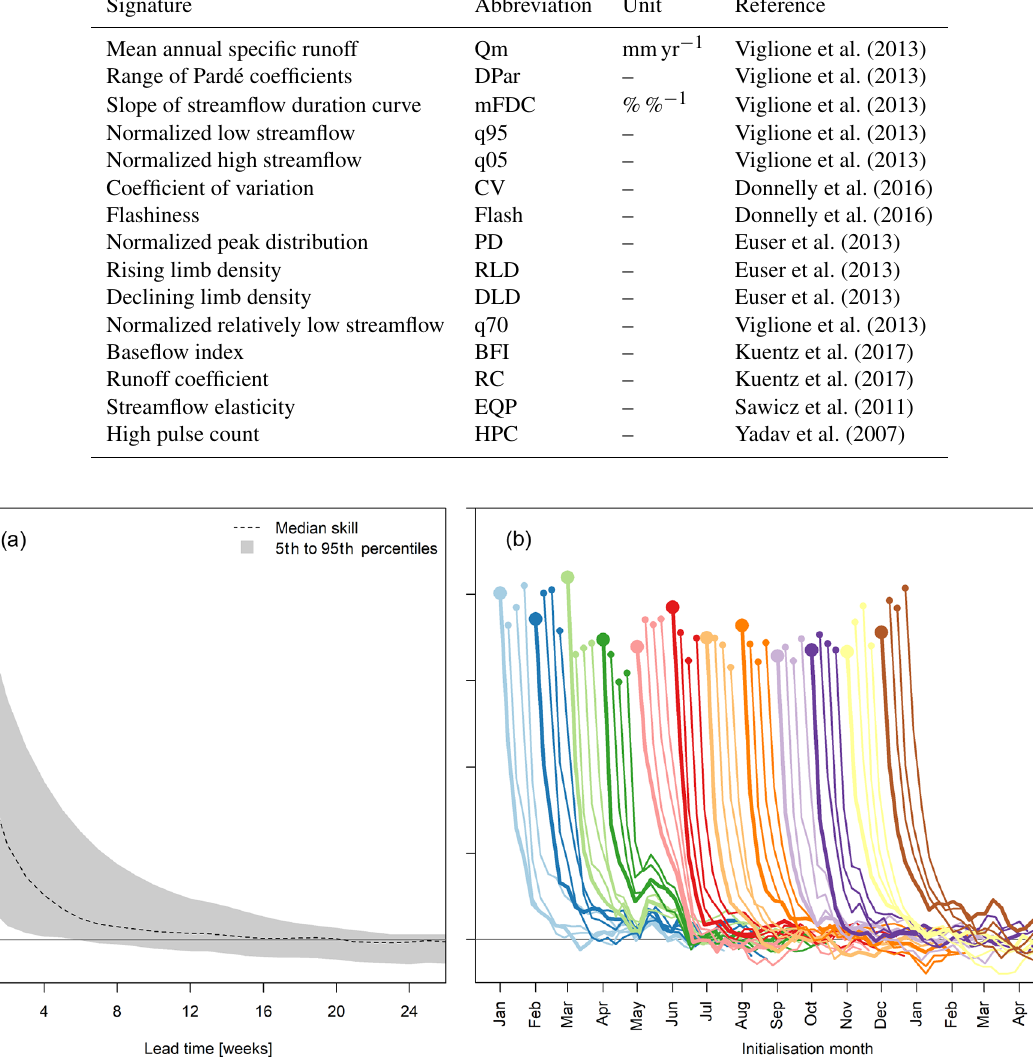
Figure 3. Streamflow ESP forecast skill (in terms of CRPSS) for 1-week forecast averages as a function of lead time and up to 190d: (a) median skill and 5th to 95th percentile range for the entire domain and (b) temporal disaggregation of forecast skill per initialization date. Initialization dates within the same month (four times) are represented with the same colour, and the first initialization of each month is marked with thicker markers and